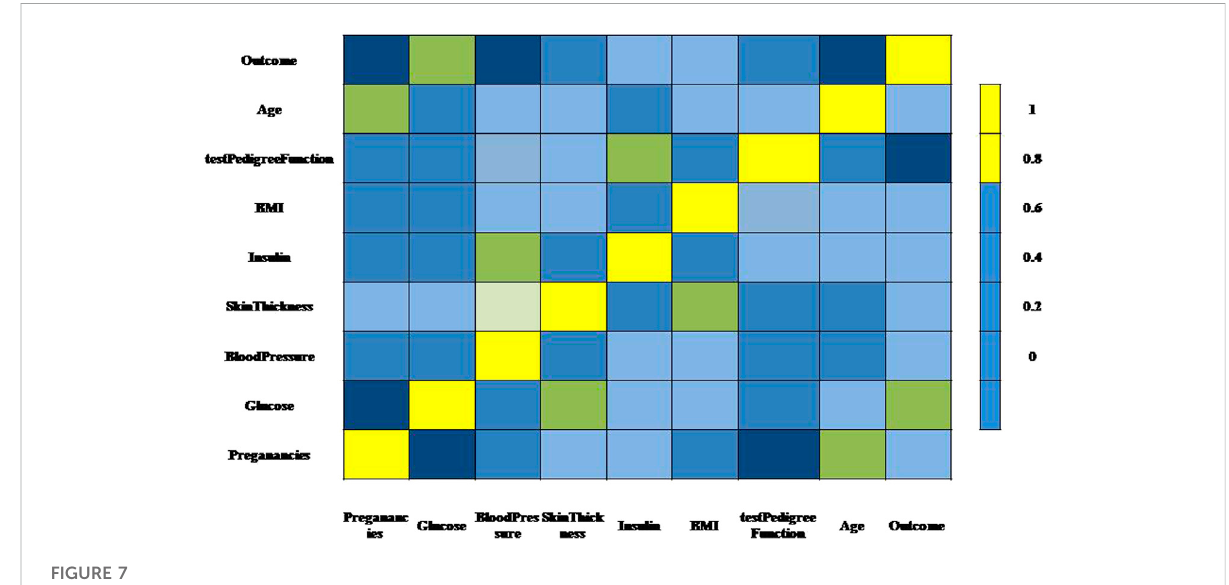
FIGURE 7 Confusion Matrix for the proposed